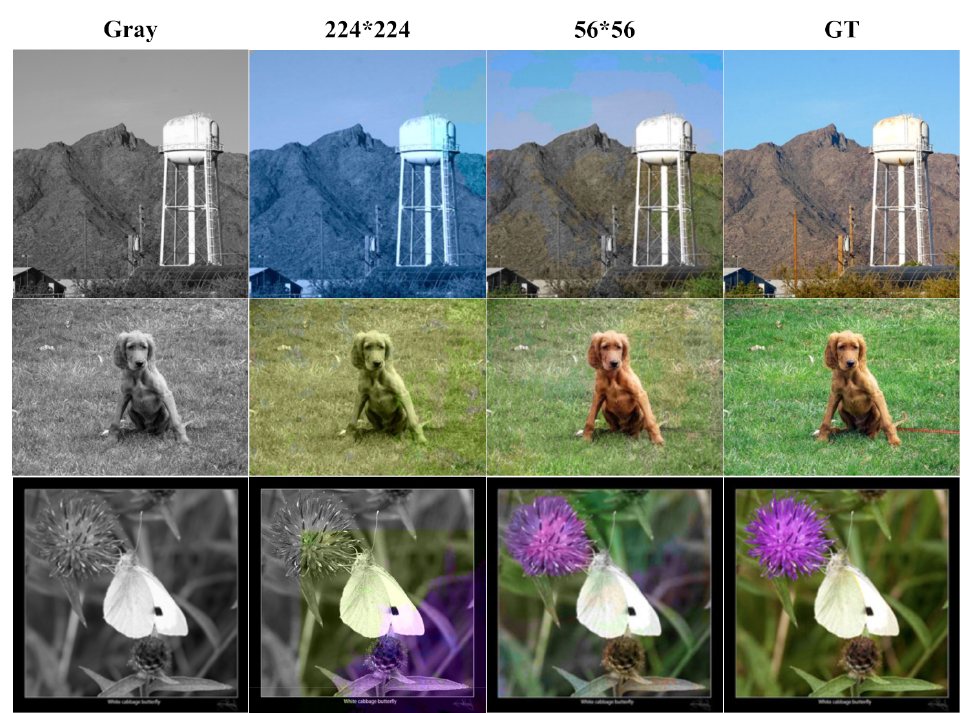
Figure 9. Colorization effect of pixel-level network. A single color (blue, green) fills the whole picture, and the last picture appears as an uneven block of